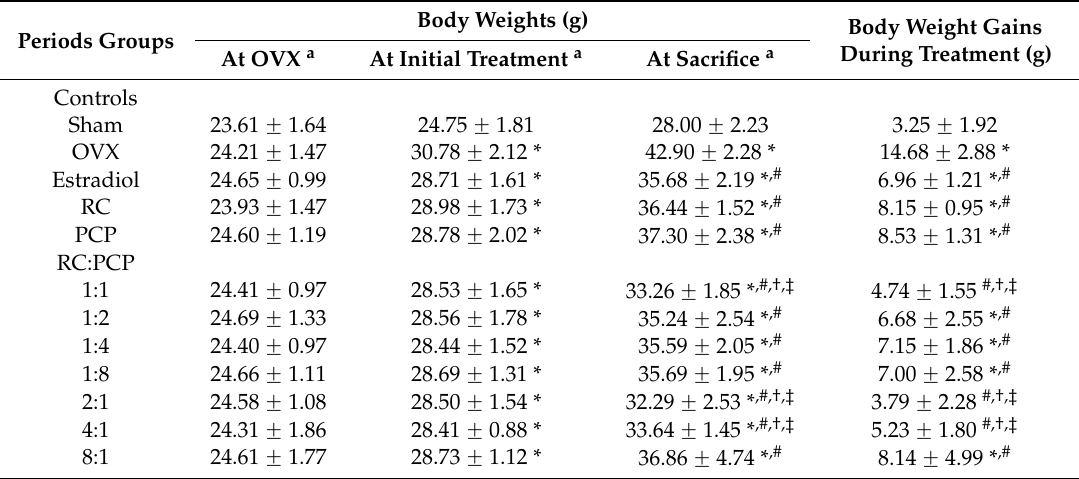
Table 2. Body weight gains in Sham-operated or OVX ddY